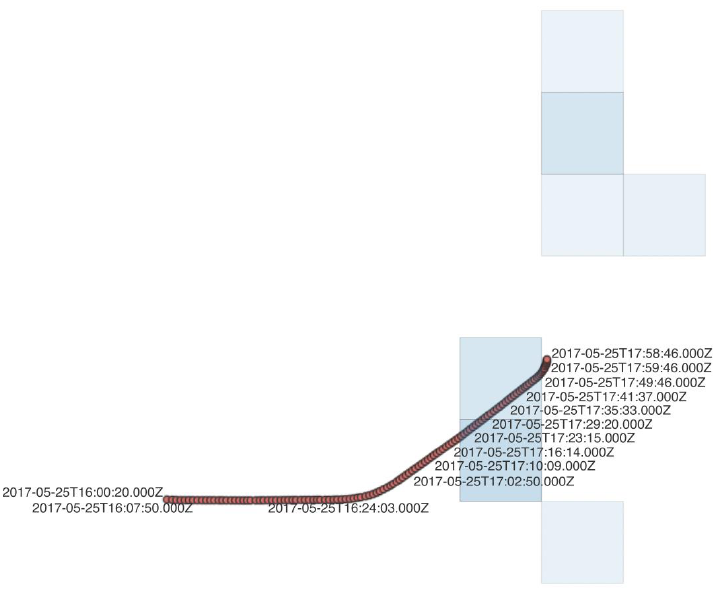
Figure 4. The output of SRP for ship 81, when using KNN.